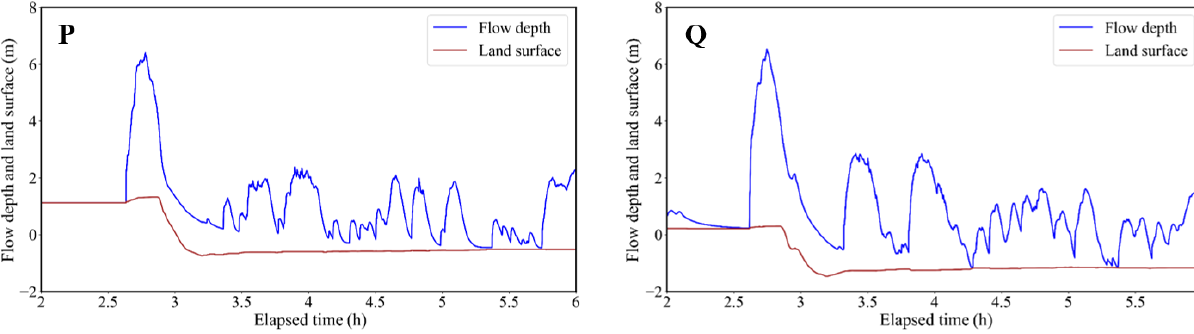
Figure 13. Chronological change of flow depth and land surface at points P and Q in regions (a) and (b) (the blue line shows the flow depth and the red line shows the land